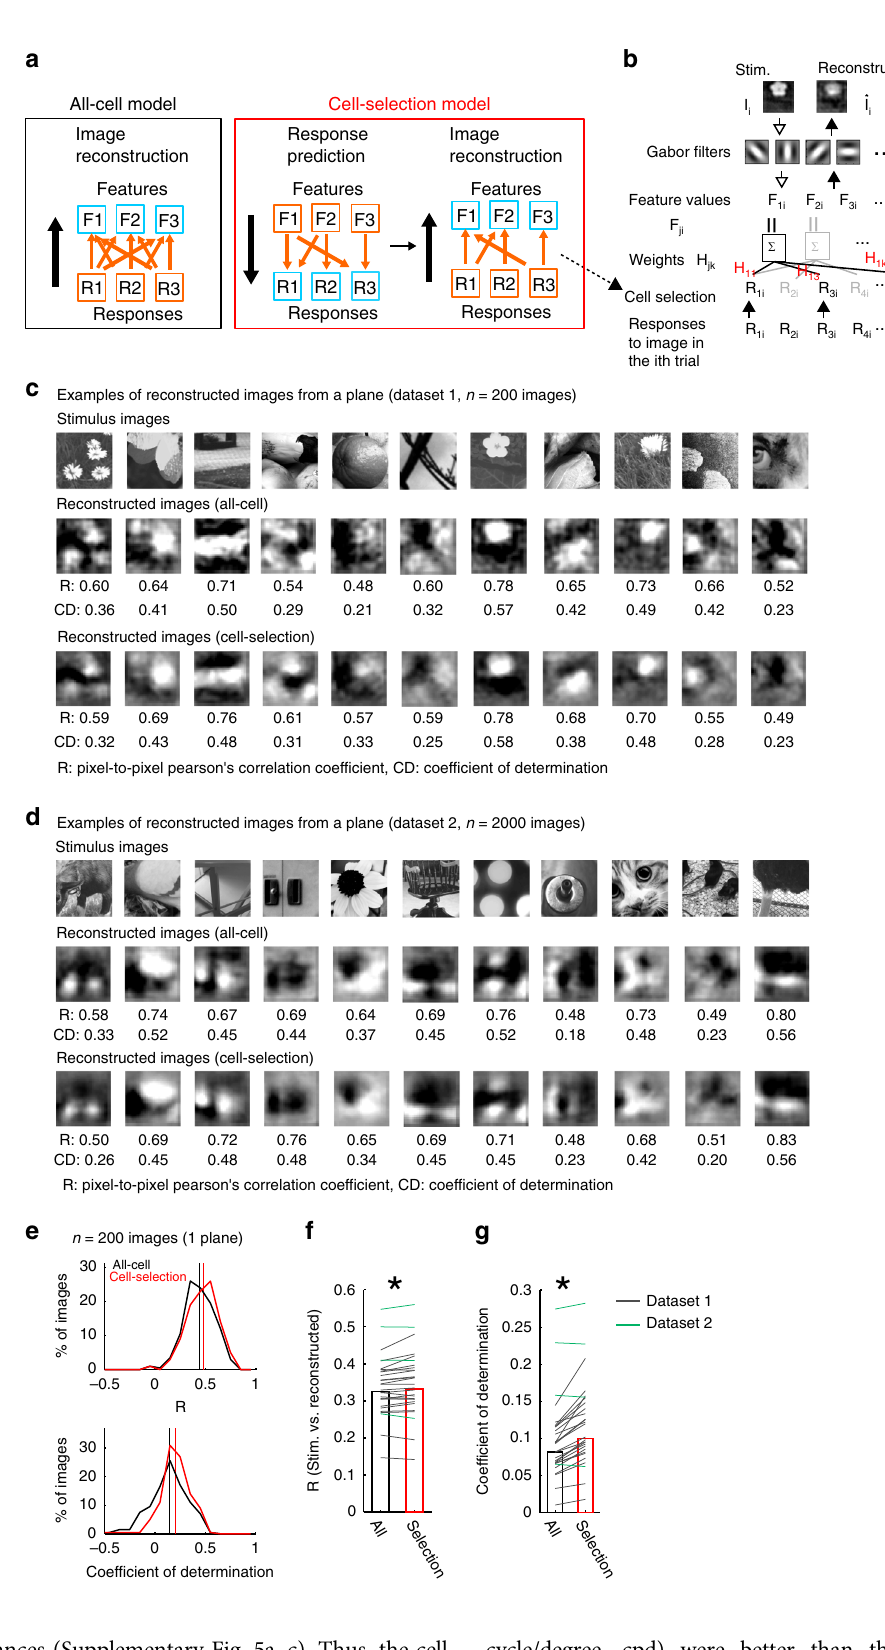
cycle/degree, cpd) were better than those of higher spatial frequencies (0.09 and 0.18 cpd; R: 0.65, 0.53, 0.18, and 0.04, and CD: 0.24, 0.23, 0.02, and − 0.03 for 0.02, 0.04, 0.09, and 0.18 cpd, respectively; Supplementary Fig. 5d – f). This may re fl ect the SF preferences of mouse V1 neurons 35